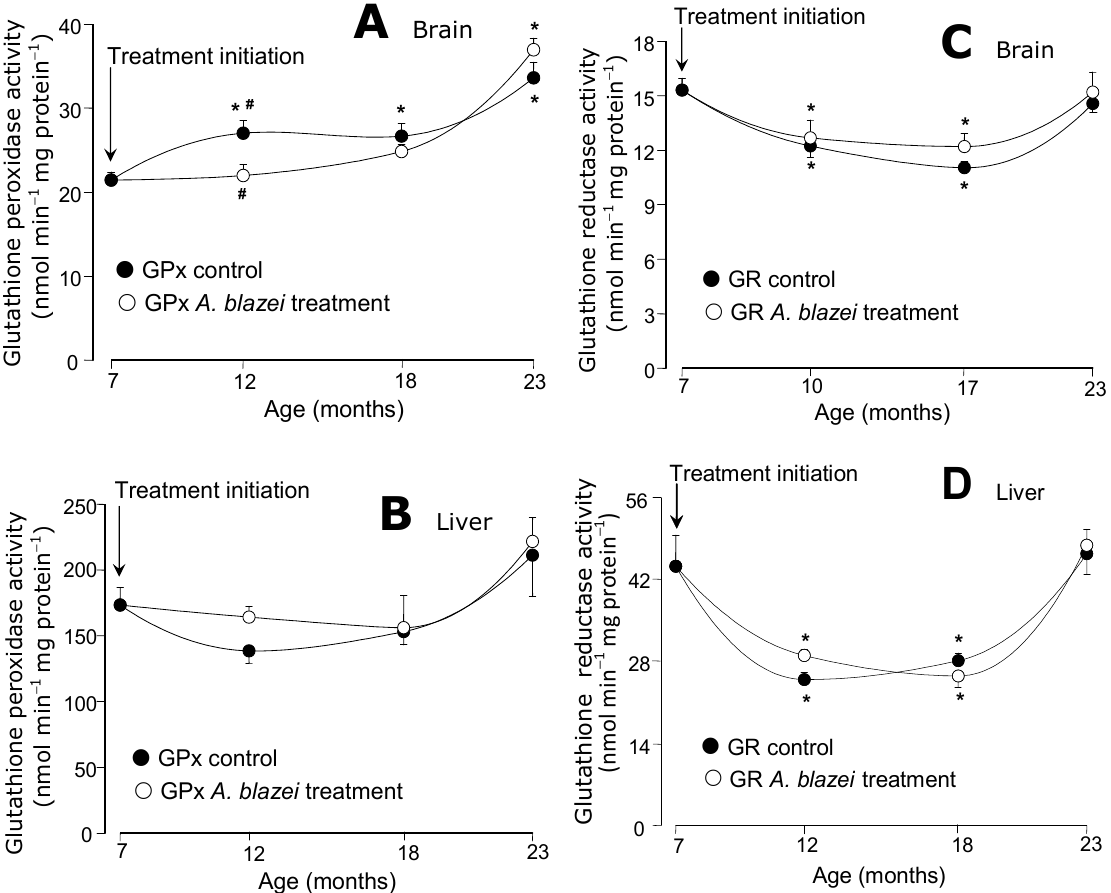
Figure 5. ( A ) Glutathione peroxidase (GPx) activities of brain homogenates. ( B ) Glutathione peroxidase (GPx) activities of liver homogenates. ( C ) Glutathione reductase (GR) activities of brain homogenates. ( D ) Glutathione reductase (GR) activities of liver homogenates. The data points represent the means ± mean standard errors of five to seven animals. The statistical analysis consisted of MANOVA followed by Duncan’s multiple range post hoc testing. Data points labeled with asterisks (*) are values significantly different ( p ≤ 0.05) from those found at 7 months (treatment initiation). Statistically different pairs of values for a given age are labeled with hashes